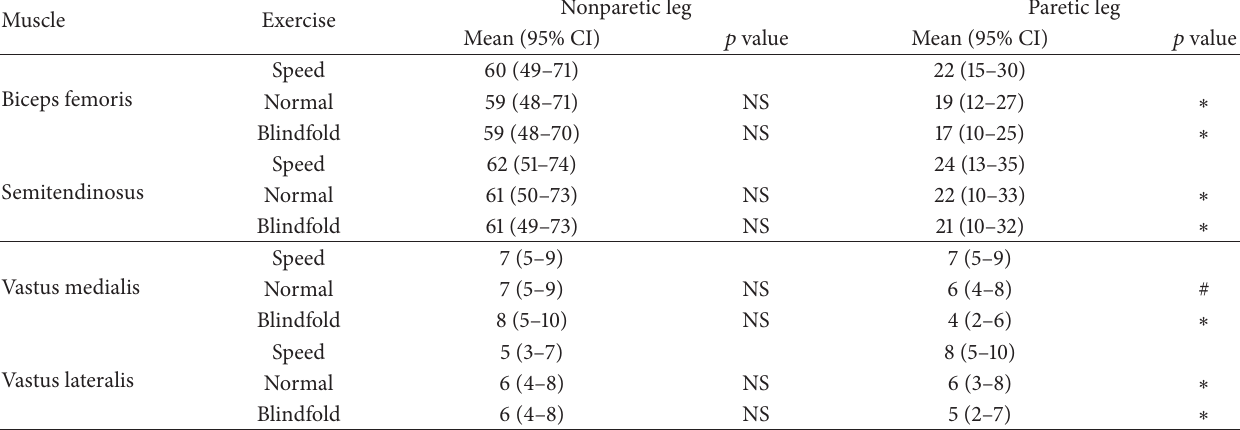
Table 2: Normalized EMG values for the biceps femoris, semitendinosus (agonists), vastus lateralis, and vastus medialis (antagonists) during knee flexion. Values are presented as least square means (LSM) ± 95% CI and represent % of maximum values. “ ∗ ” denotes a significant difference compared with the “speed” condition whereas “#” indicates a significant difference between “normal” and “blindfold.”